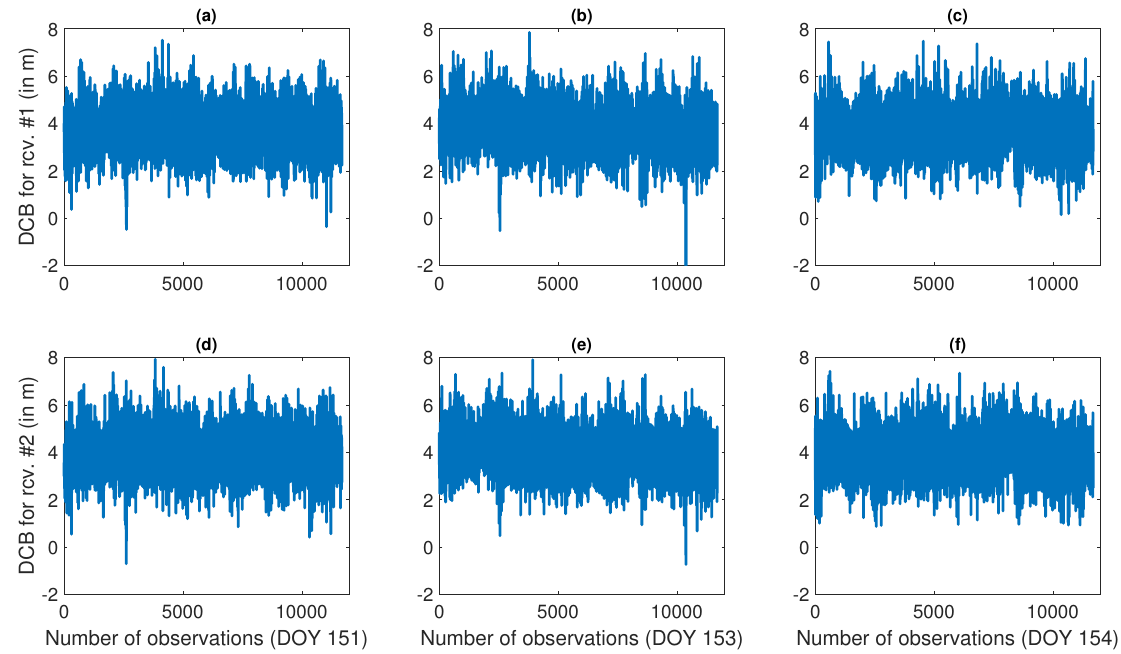
Figure 2. DCB between L2C-L1 C/A ionosphere-free combinations and L1 C/A. Results from three 24h data sets, each collected with two receivers on days 151 ( a , d ), 153 ( b , e ) and 154 ( c , f ) of